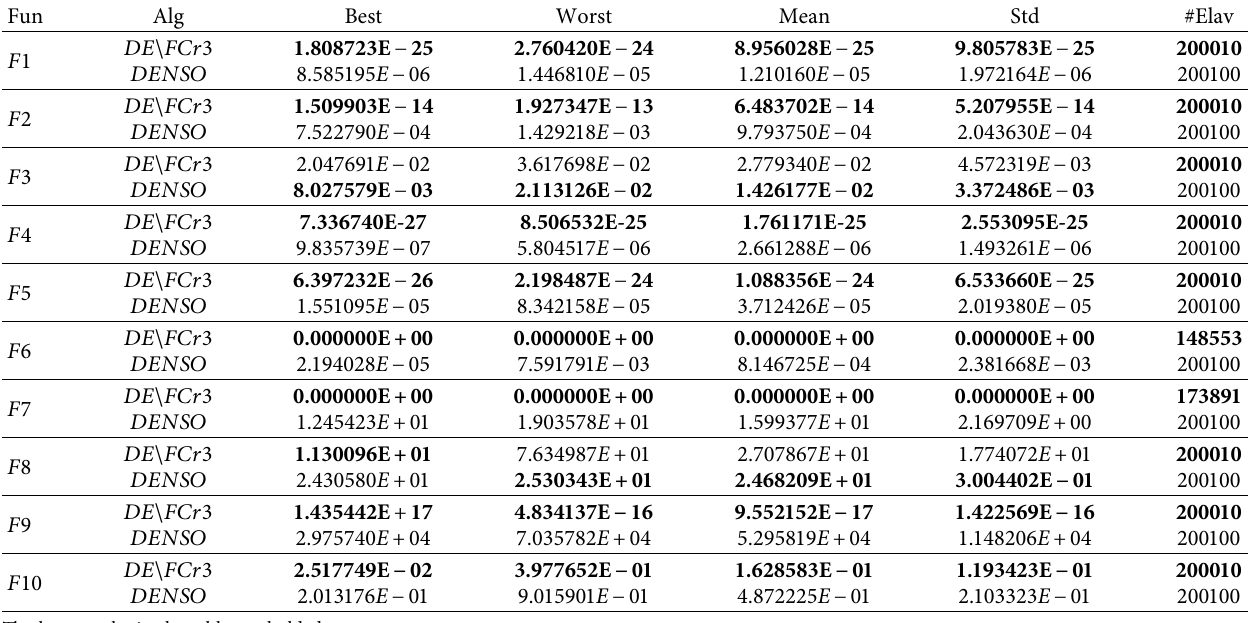
Table 5: Result comparisons between DE \ FCr 3 and DENSO for F 1– F